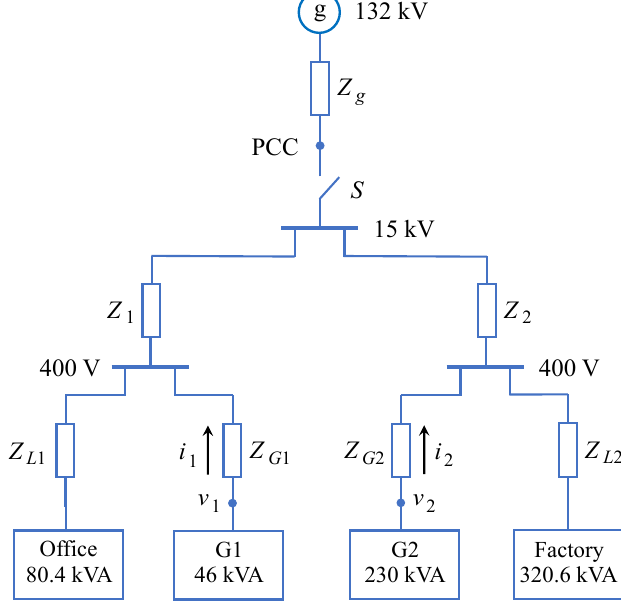
Figure 1. Diagram of the 500 kVA microgrid considered in this study.